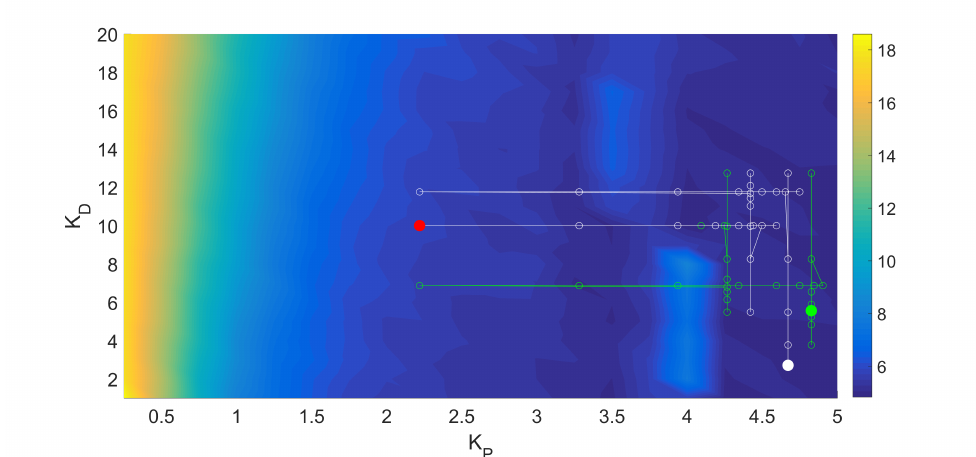
Figure 16. The altitude controller gains and J = f ( k P , k D ) values during auto-tuning process using GLD method for nominal case (white color) and at the presence of wind gusts (green); k Dinit = 10 (marked in red).